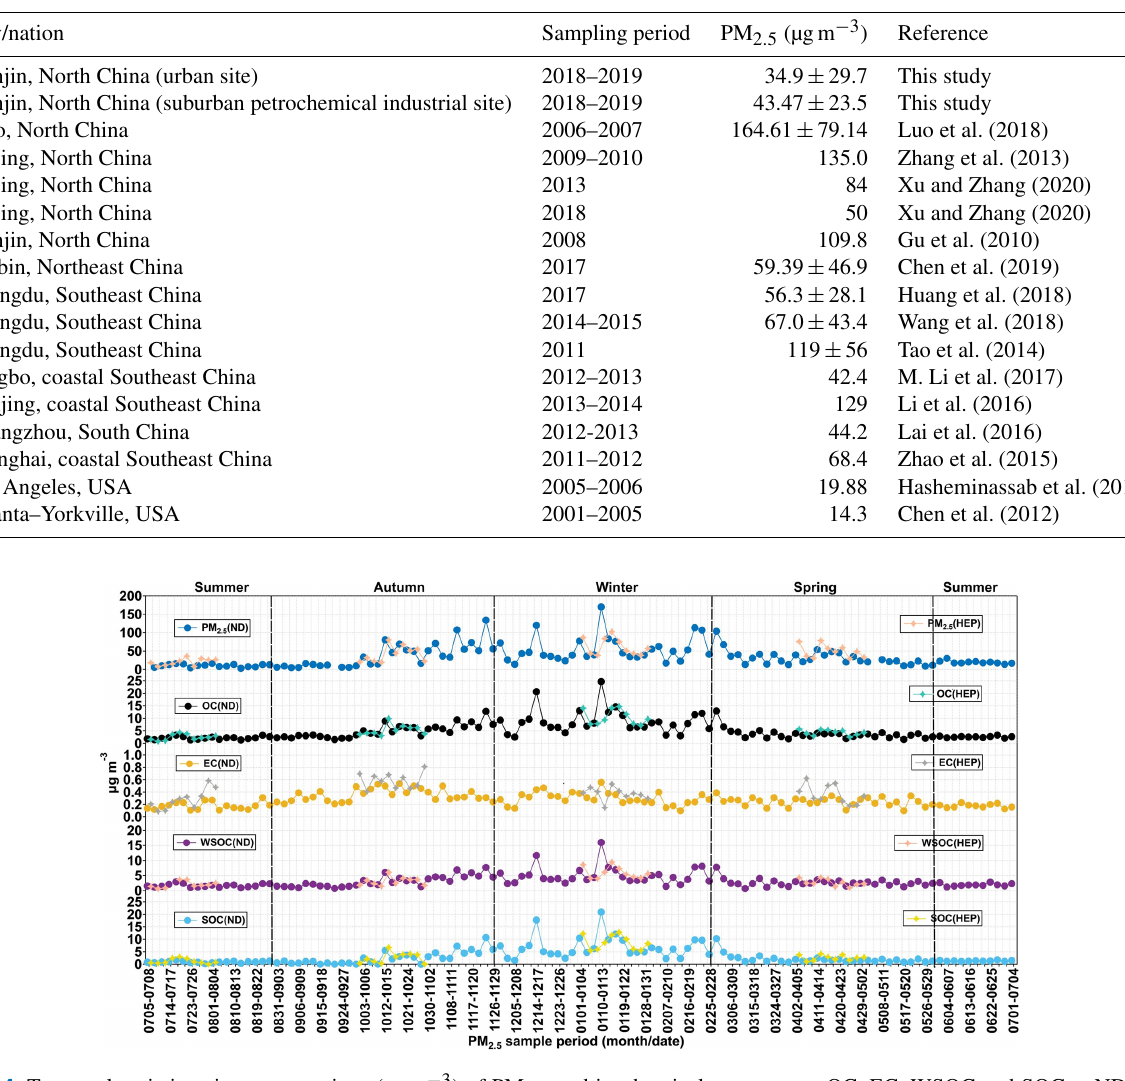
The average OC / EC was 17.8 at ND and 15.7 at HEP, which are 8.7 and 7.8 times higher than 2.0, which